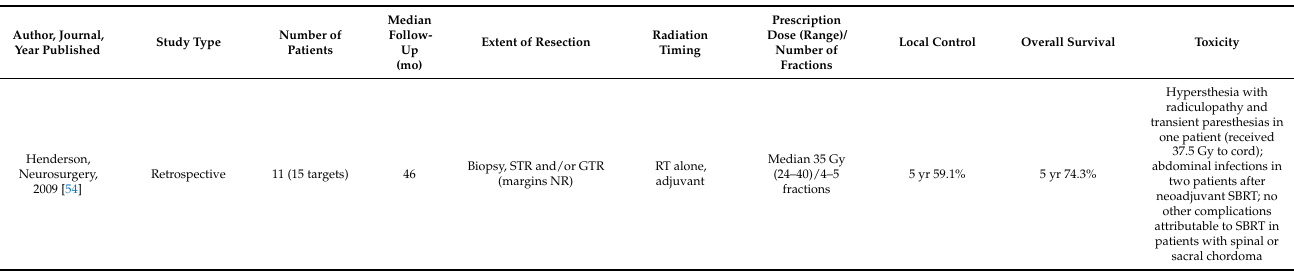
Table 3. Data summary of studies reporting outcomes of patients with spinal and sacral chordomas treated with stereotactic radiation